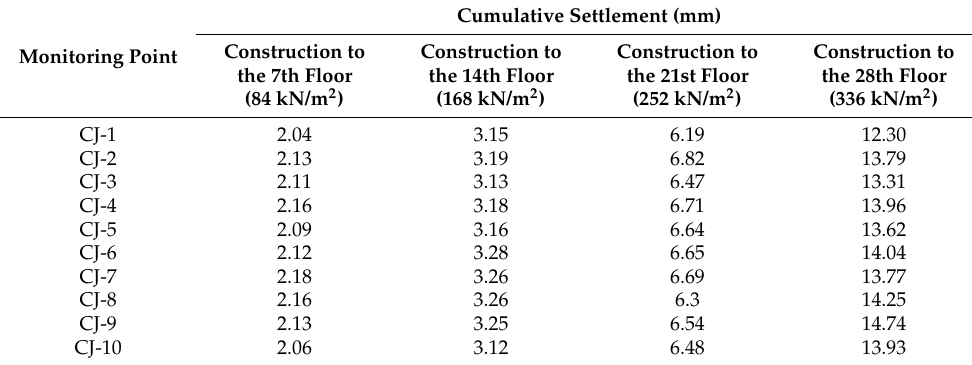
Table 5. Settlement of monitoring